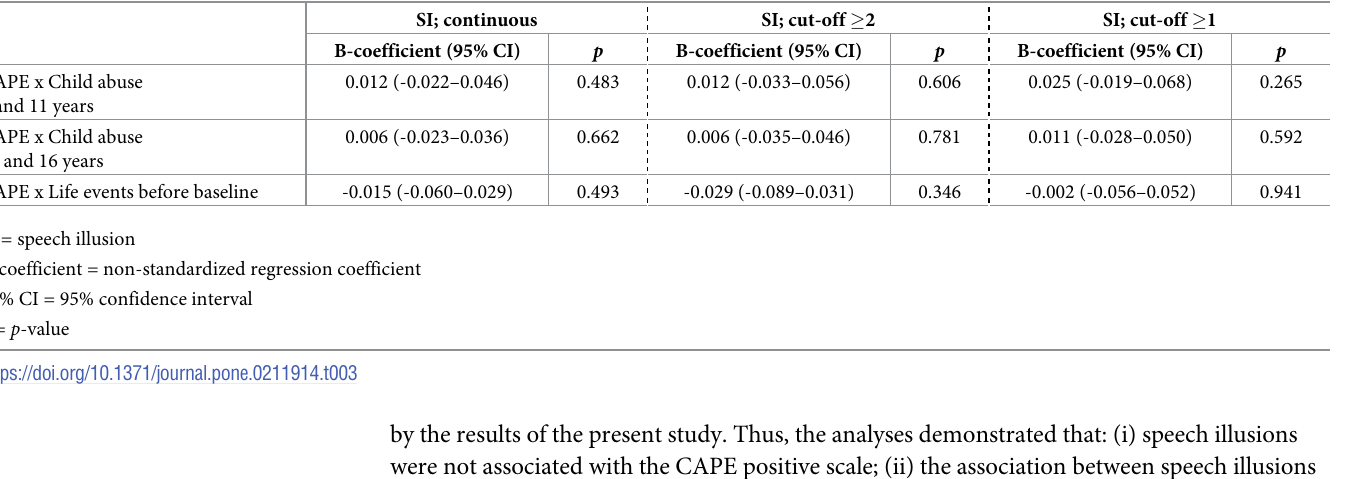
Table 3. Interaction between CAPE positive scale and childhood trauma or life events.